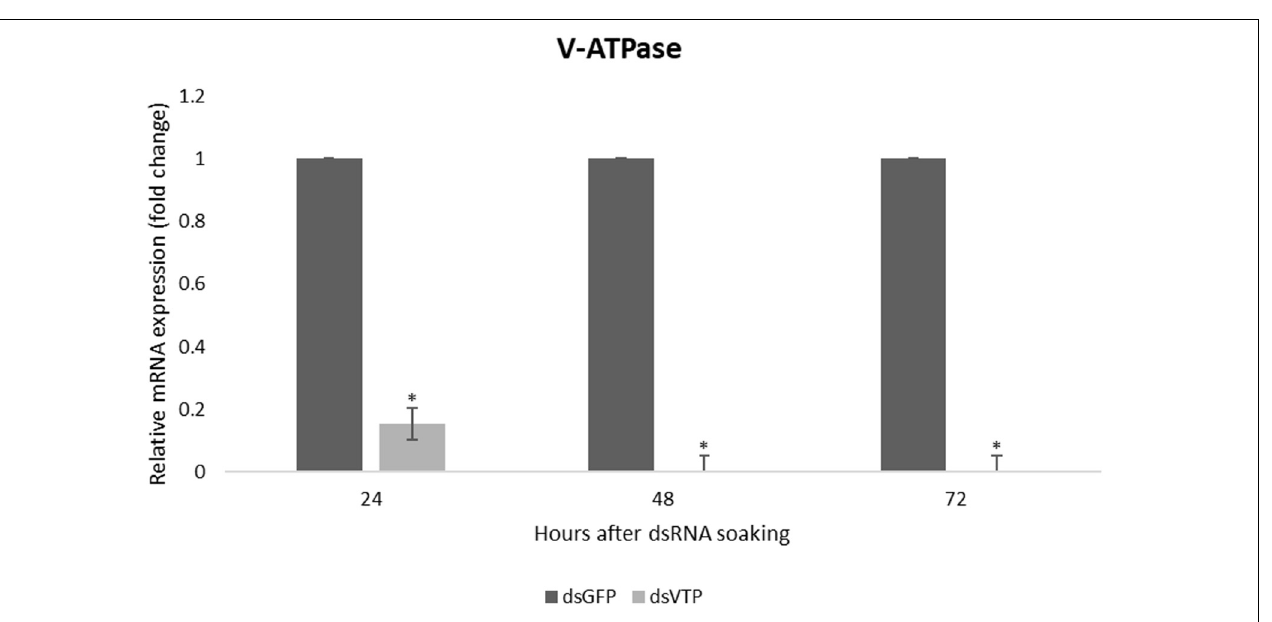
FIGURE 5 | Relative mRNA expression of V-ATPase in Anastrepha fraterculus larvae after 24, 48, and 72 h of soaking in dsRNA (500 ng/ µ l). The mRNA levels were normalized using α -tubulin and actin as reference genes. The columns represent the mean ± SE ( n = 3). ∗ p ≤ 0.05 ( t